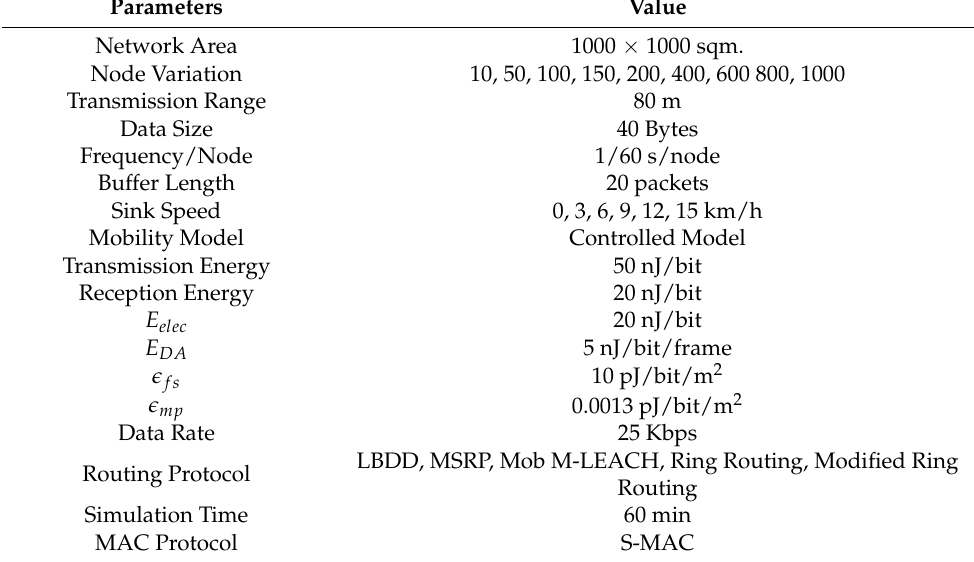
Table 2. Simulation